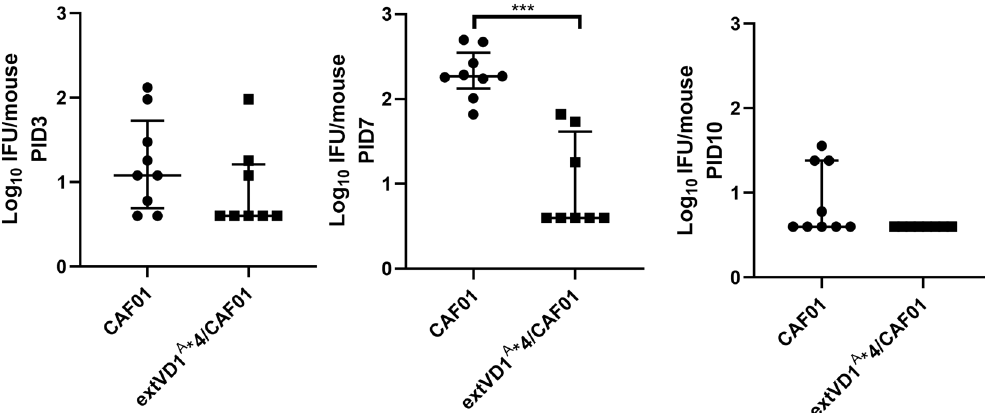
Fig. 7 Protective effect of extVD1 A *4/CAF01 induced immune responses against SvIa challenge. A/J mice were immunized with extVD1 A *4/CAF01 ( n = 8) or CAF01 alone ( n = 9) using the SIM vaccination protocol. Six weeks post last vaccination, the mice were challenged i.vag. with 1 × 10 6 IFU of SvIa/mouse. Data are presented as log 10 IFU. Each line represents the median number of IFU with 25th and 75th percentiles recovered from vaginal swabs at days 3, 7, and 10 post infection. A Mann – Whitney test was used for comparison among groups. *** p <